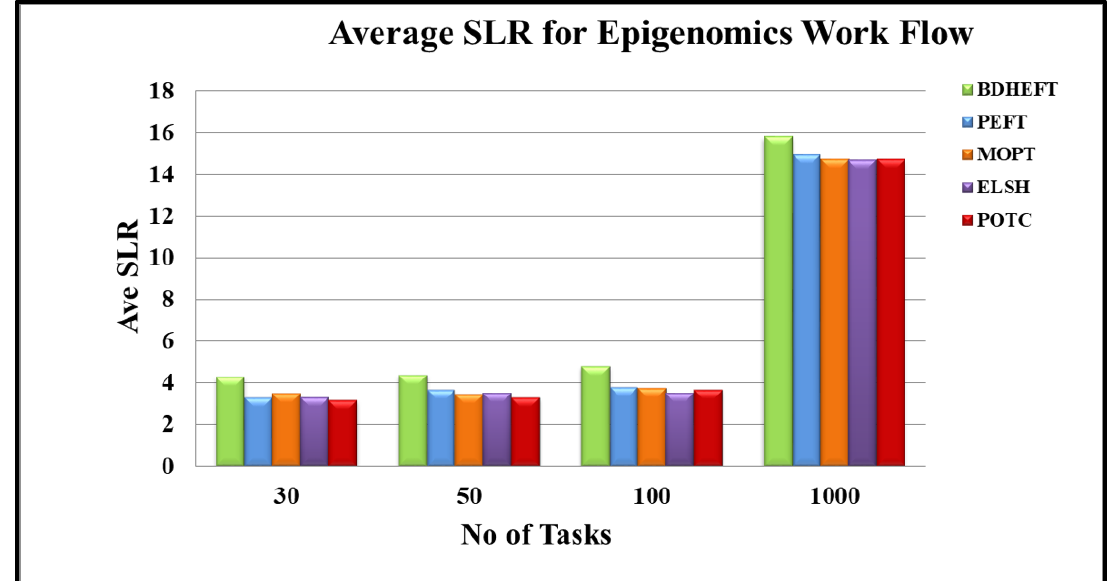
Figure 4. Average schedule lengths ratio for the epigenome workflow.